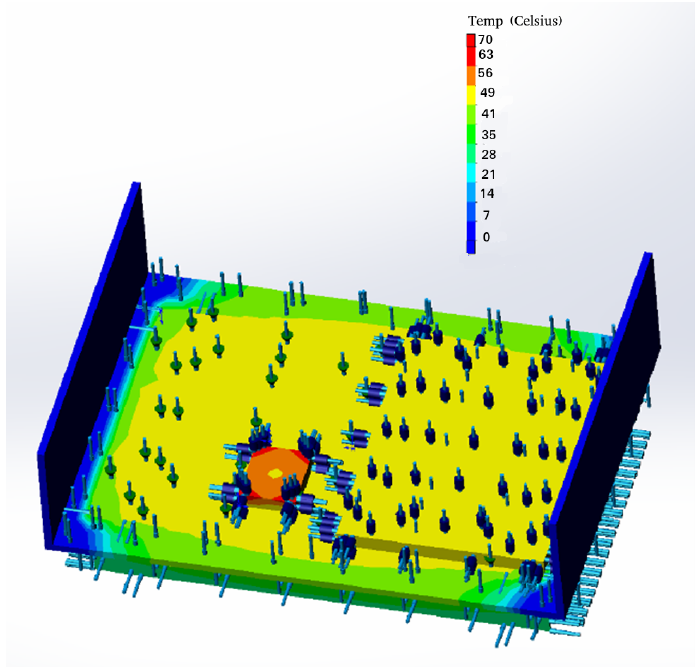
Figure 8. Model of the temperature distribution along the inner side of the control computing unit. The simulation results show the high efficiency of the developed architecture in the distribution of thermal loads.